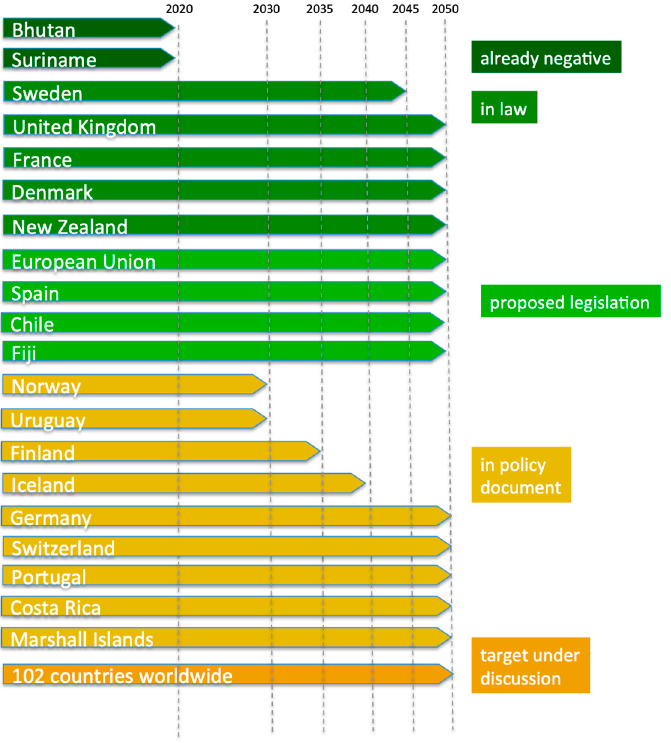
Figure 3. Decisions on climate neutrality (authors’ illustration based on Energy & Climate Intelligence Unit [17]).